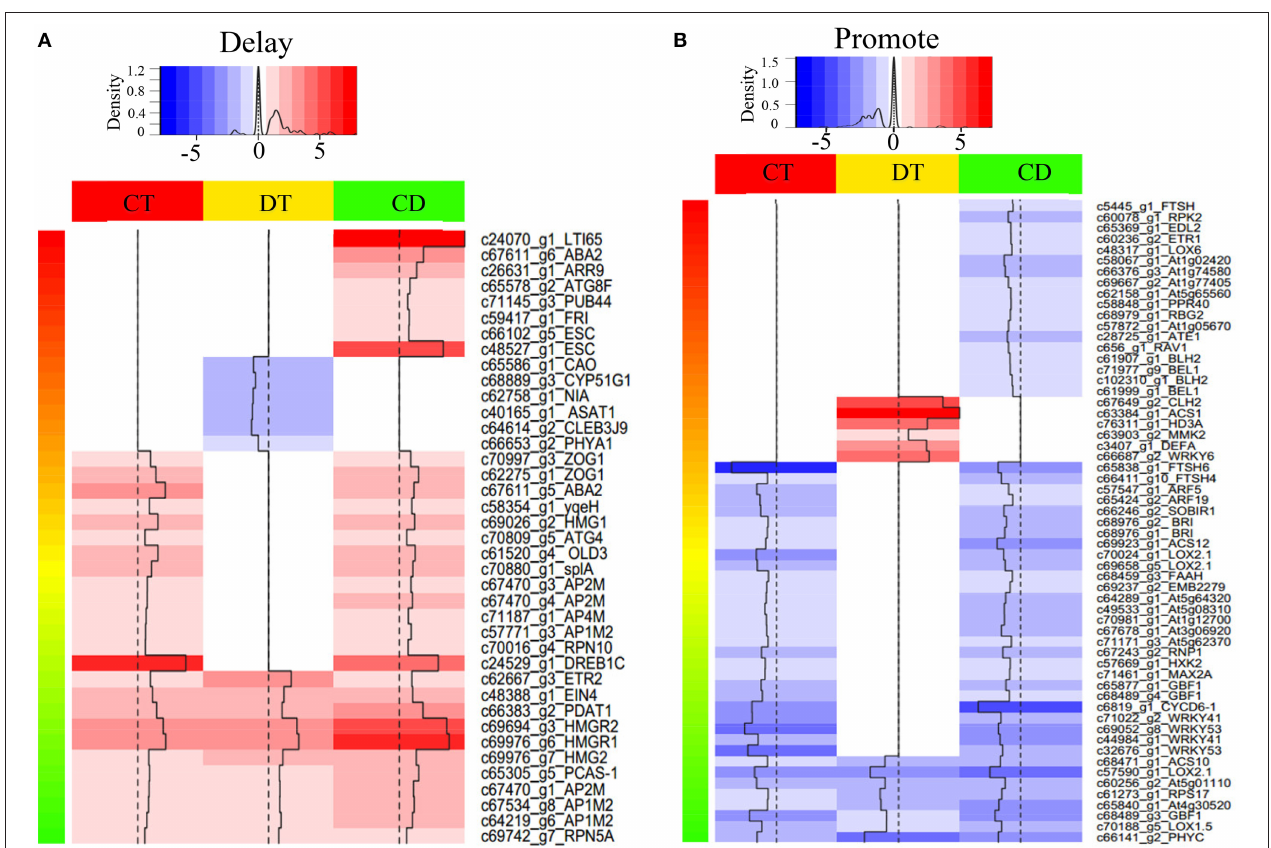
FIGURE 4 | Heat map of selected differentially expressed SAGs with known effect. Heat map shown the expression level of SAGs with promote (A) or delay (B) effect in LSD. The selection was based on the clustering analysis results (i.e., mode 1, 2, 5, 6, 9, 10, 11, 12, 15, 16, 19, and 20 in Figure 3 ). Color indicates fold change of DEGs under CT, DT and CD, as shown in the